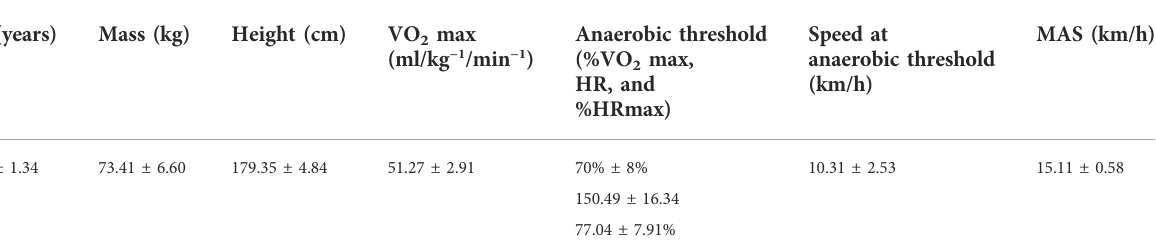
TABLE 1 Sample characteristics (mean ± SD) ( n =